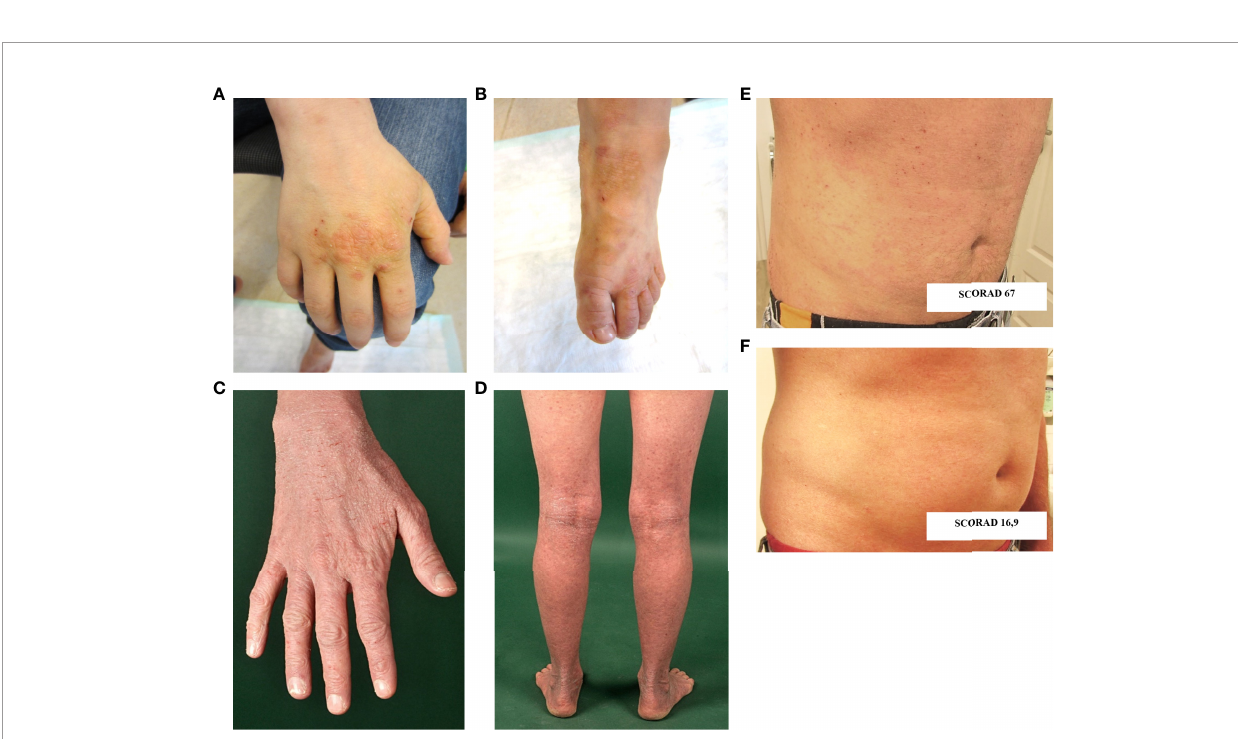
FIGURE 2 | Cutaneous fi ndings. (A, B) Hand and foot eczema in patient III.4. (C, D) Extensive eczema in patient III.2. (E, F) Skin fi ndings prior (E) and following (F) treatment with dupilumab in patient III.1. SCORAD: SCORing Atopic Dermatitis; Clinical scoring system to evaluate severity of atopic eczema. Interpretation: < 25 mild, 25-60 moderate, 61-103 severe atopic eczema.